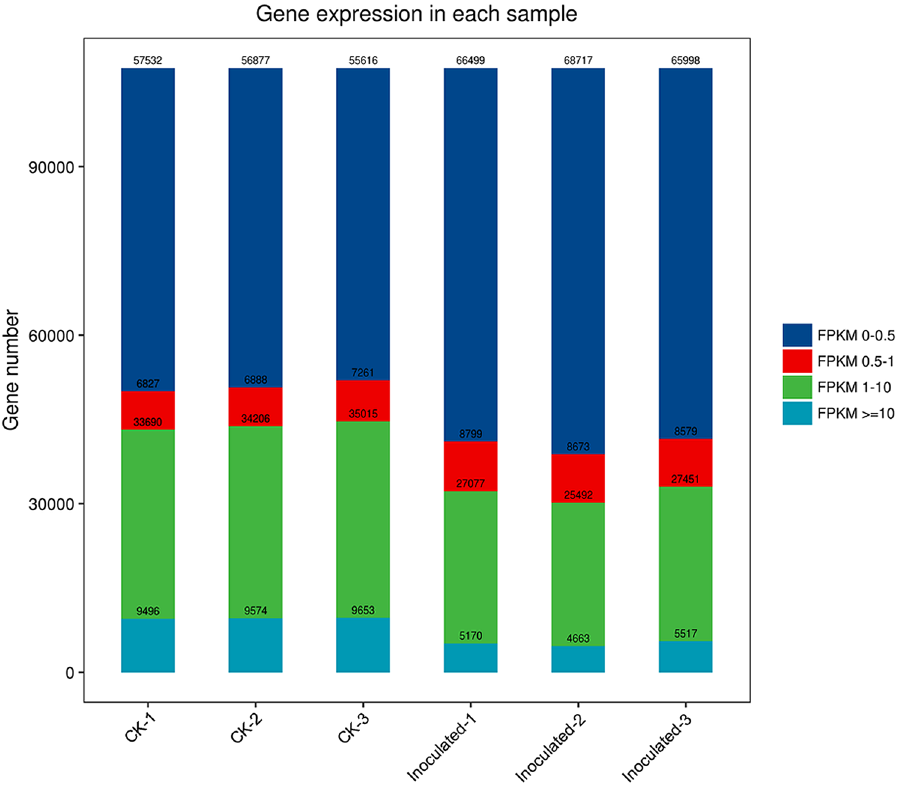
Figure 1. Summary of differentially expressed genes (DEGs). Numbers of DEGs between CK and T. controversa infection. CK indicates mock plants, and Inoculated indicates plants infected by T.